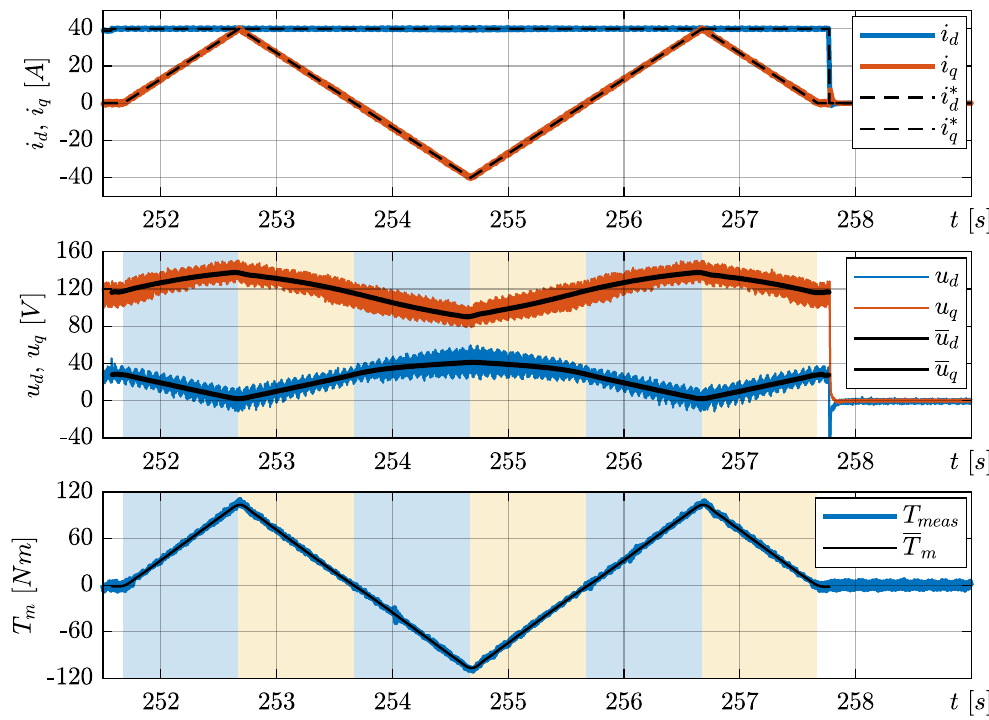
Figure 13. Identification sequence for one current combination i d = 40 A and i q = − 40..40 A at n m = 500 rpm.